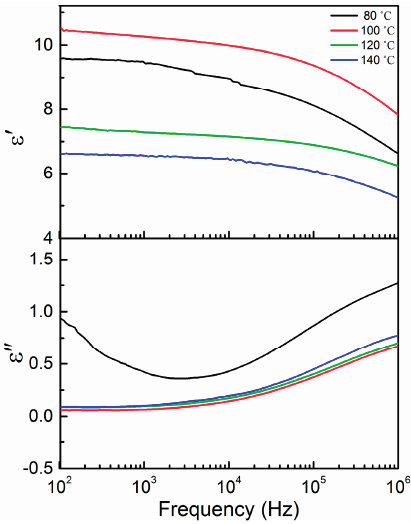
Figure 8. Room temperature dielectric frequency spectra of P(VDF-TrFE)treated with various annealing